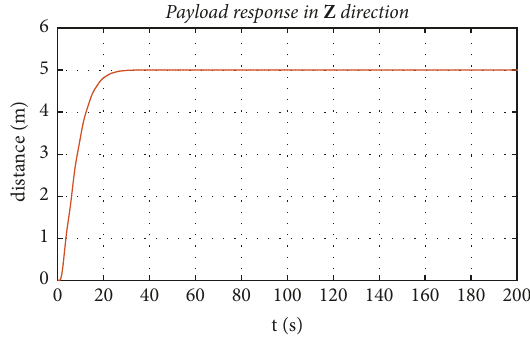
Figure 12: Payload response in Z direction with vibration control.